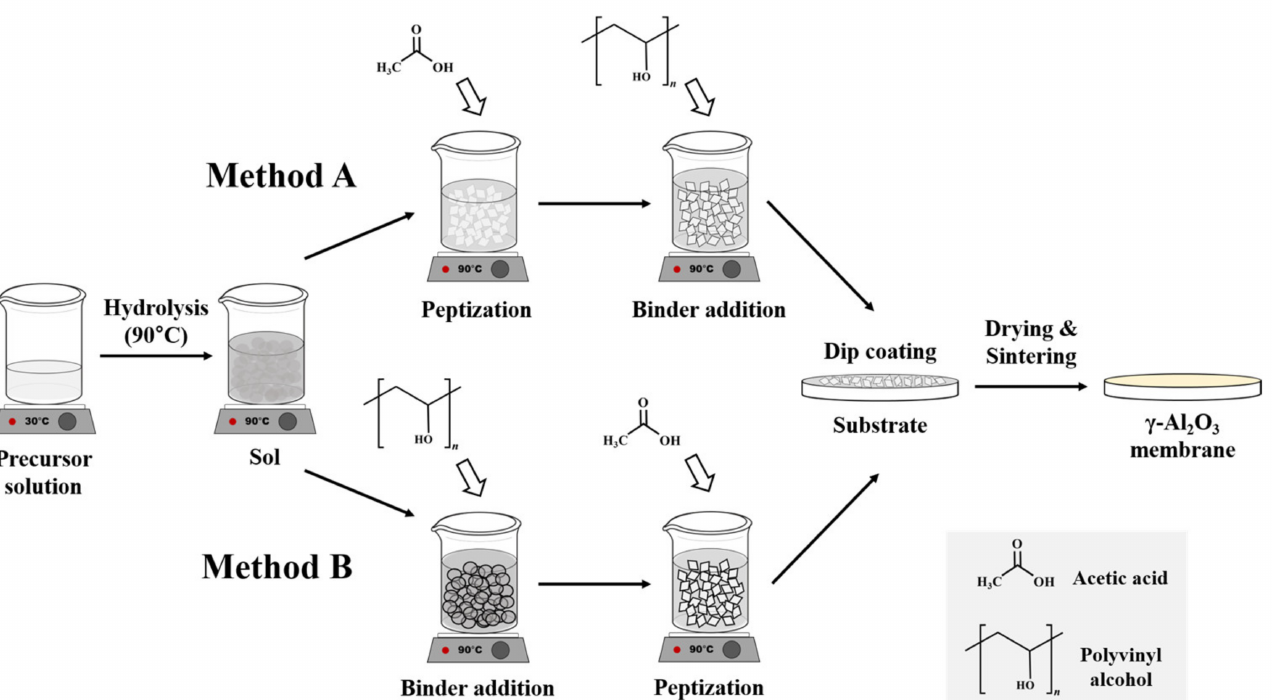
Figure 1. Schematic diagram for the preparation of γ -Al 2 O 3 ultrafiltration (UF) membrane using the sol-gel methods A and